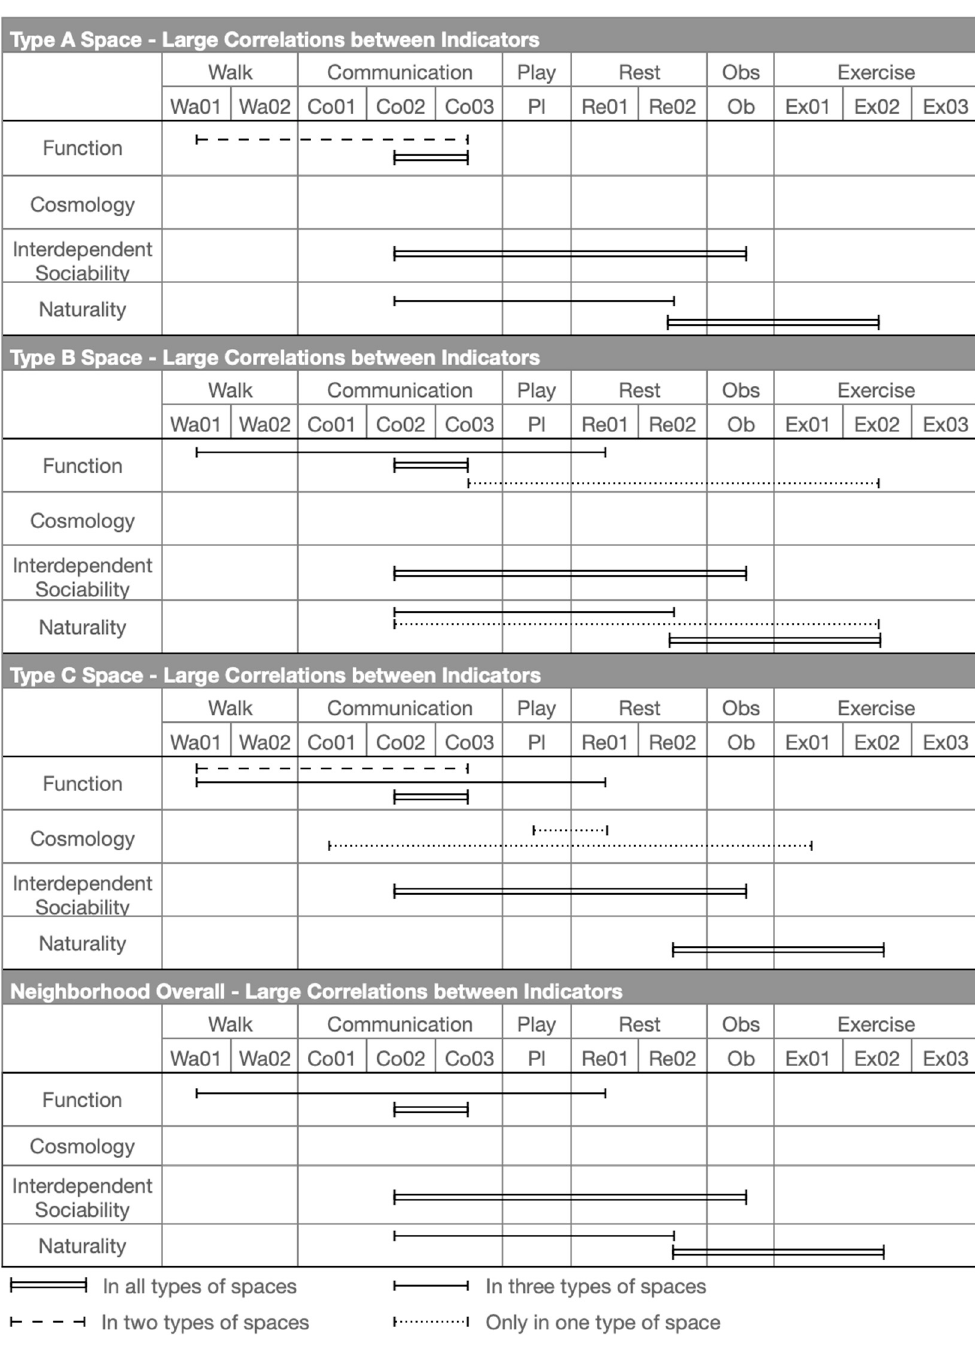
Figure 10. The large corrections between types of users’ behaviour in relation to local place qualities. Natural elements are highlighted in the use of all types of spaces in the